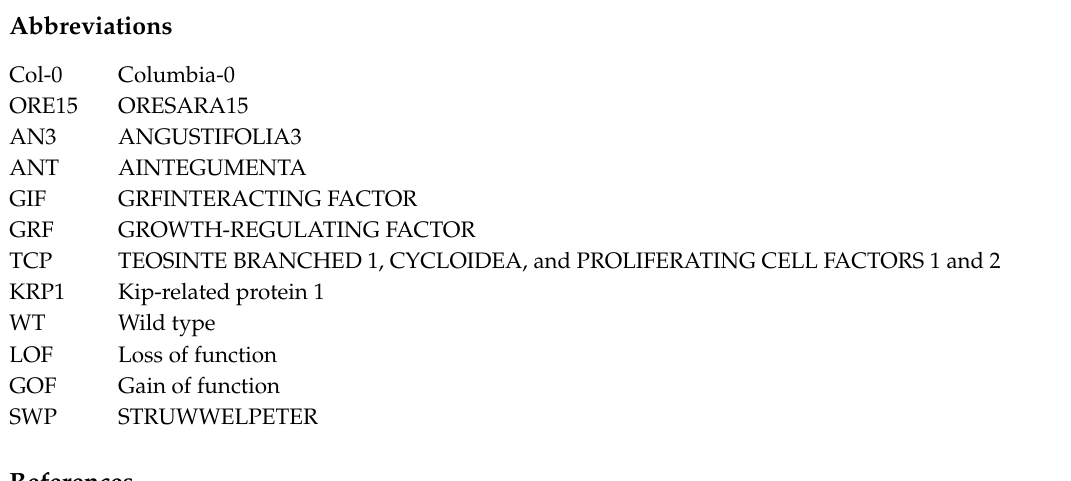
Figure S1: The relative alteration in cell number in a leaf from LOF and GOF single mutants and the combined mutants as in the corresponding control, Col-0 (WT), Figure S2: Distribution of DNA content in third leaves from Col-0 (WT), ore15-2 mutant, and ore15-1D mutant plants during leaf development, Table S1: The area and width of mature 3rd leaves of Col-0 (WT), LOF and GOF single mutants, and the combined double mutants at 21 DAS, Table S2: The total number and area of palisade mesophyll cells in mature 3rd leaves from Col-0 (WT), LOF and GOF single mutants, and the combined double mutants at 21 DAS, Table S3: List of oligonucleotide primers used in this